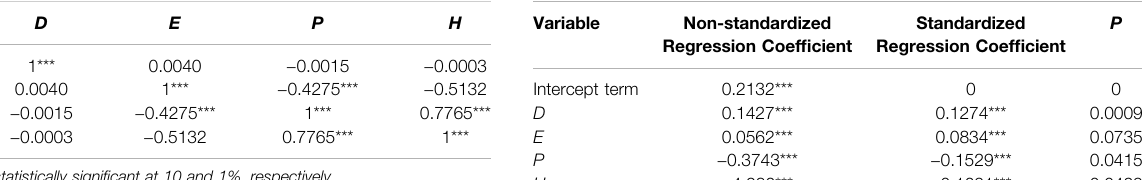
TABLE 3 | Test results of QAP correlation between in fl uencing factors. TABLE 4 | Results of the QAP regression analysis of in fl uencing